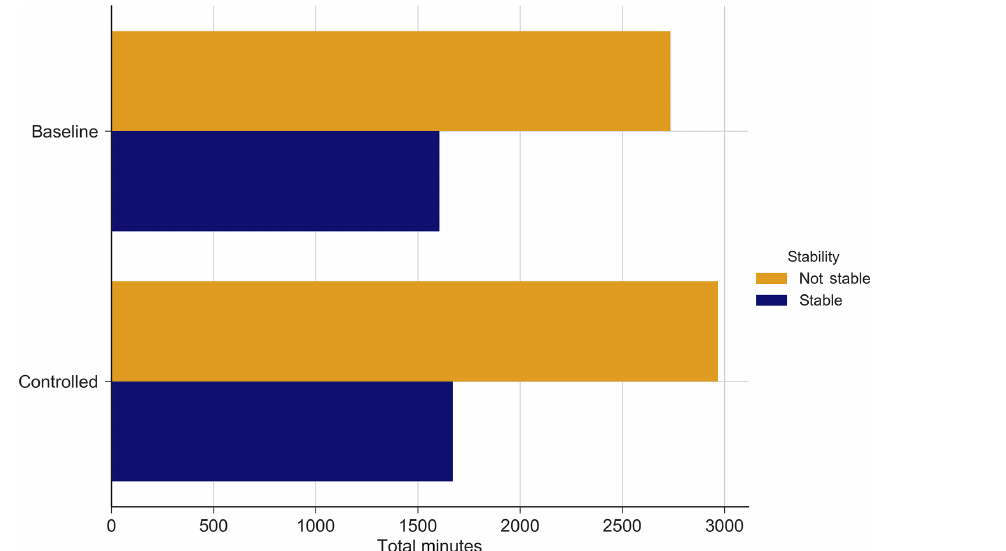
Figure 6. Total data collection. The yellow bars indicate the data from unstable conditions, and the blue bars indicate the data from stable conditions. The data were collected for both the baseline and controlled